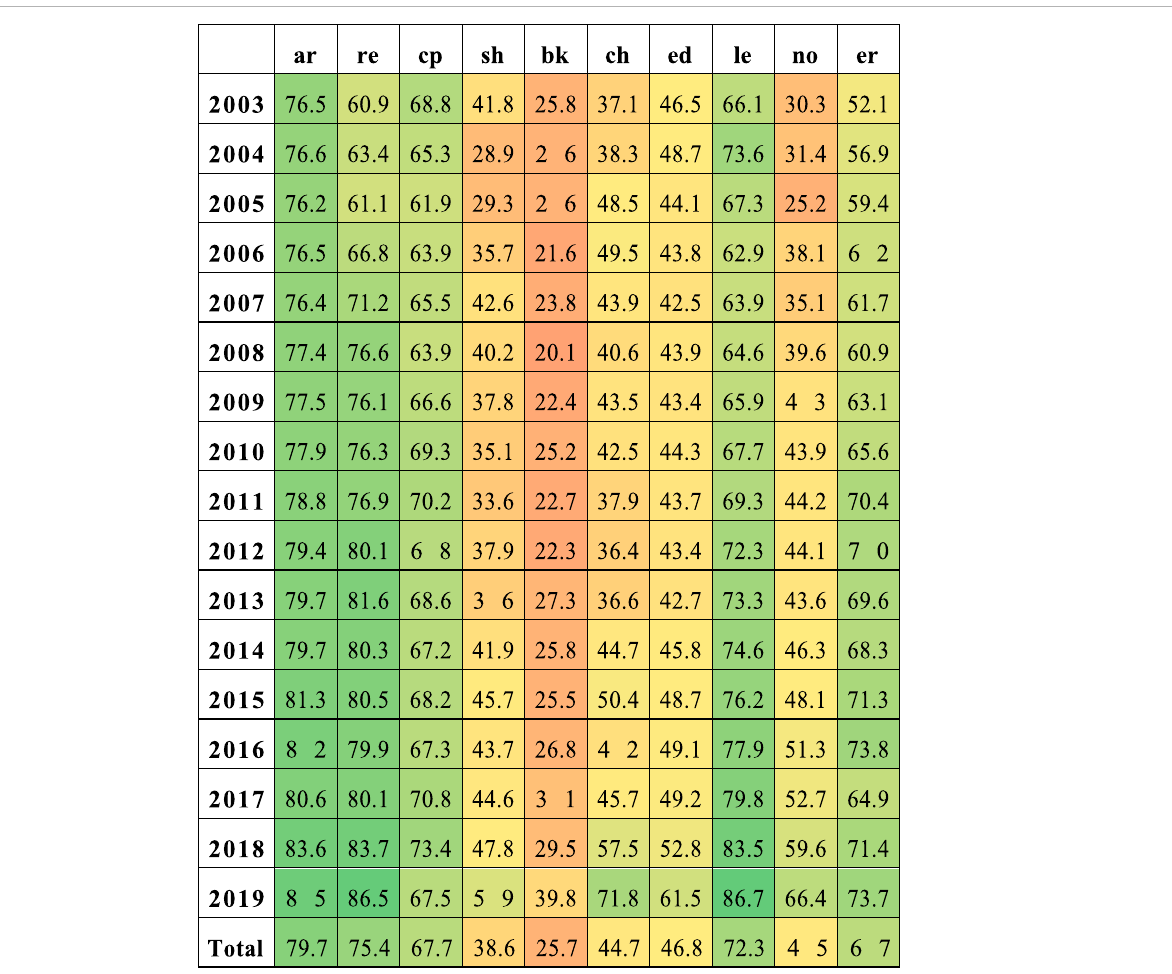
TABLE 2 | Scopus matching percentages by most frequent document